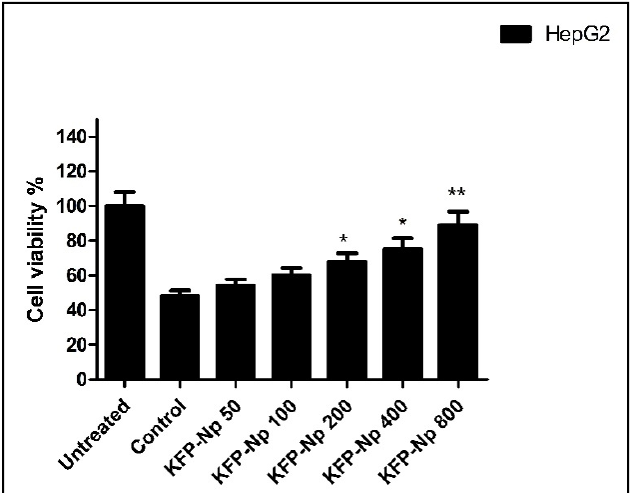
Figure 5. Protective effect of the KFP-Np against CdCl 2 -induced cytotoxicity in a hepatocyte cancer